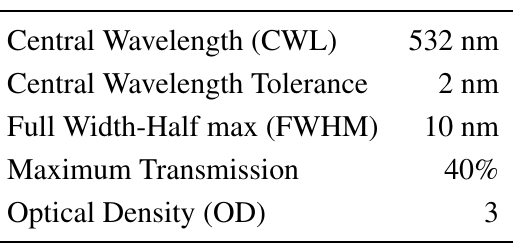
Table 2. Optical filter